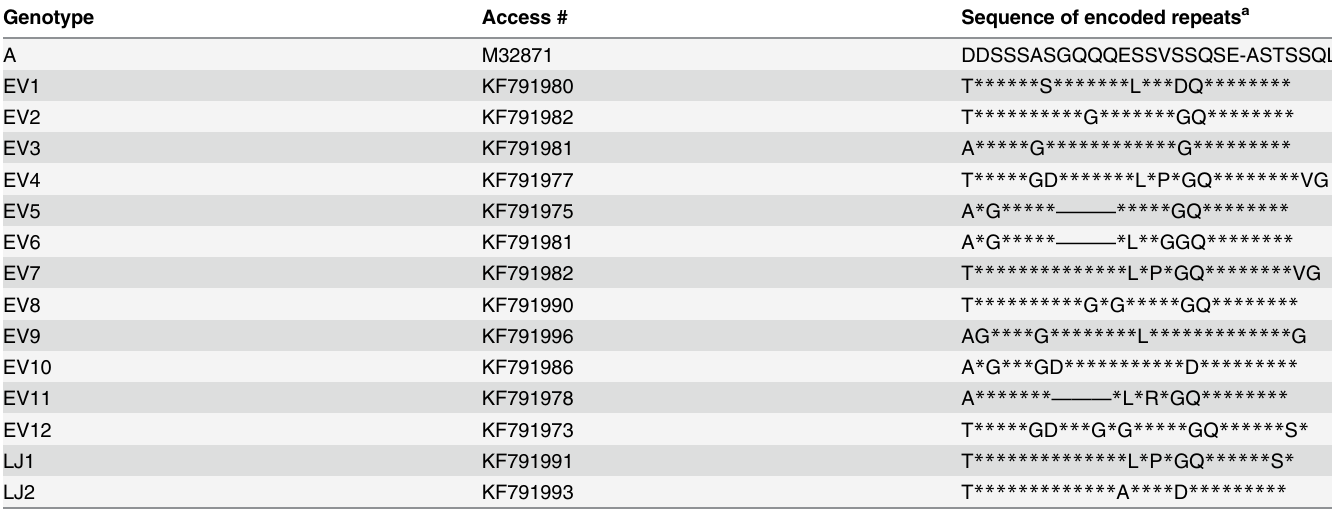
a Comparison to the prototype A . marginale Florida strain Msp1a tandem repeat (A) with repeats found in El Verdine ñ o (EV) and La Joya (LJ) infected animals. A star ( * )indicates an identical amino acid and a dash indicates a